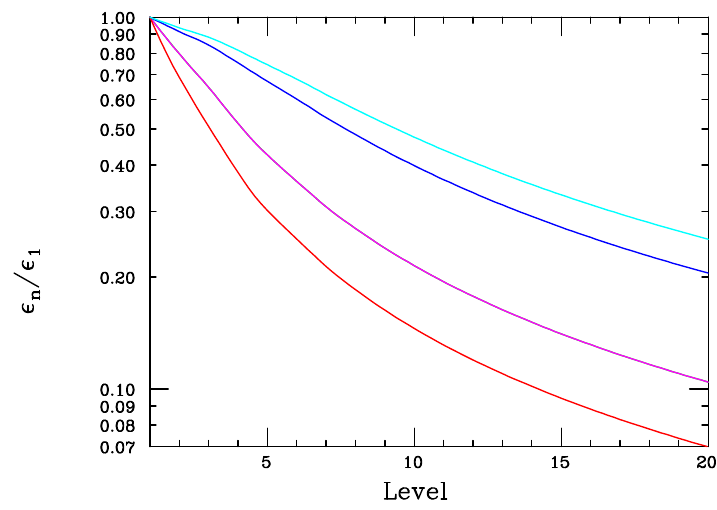
Figure 4 . Values of (cid:15) n =(cid:15) 1 appearing in the DM annihilation cross sections as a function of the KK level n for BM1/BM1’ (magenta), BM2 (blue), BM3 (red) and BM4 (cyan). The